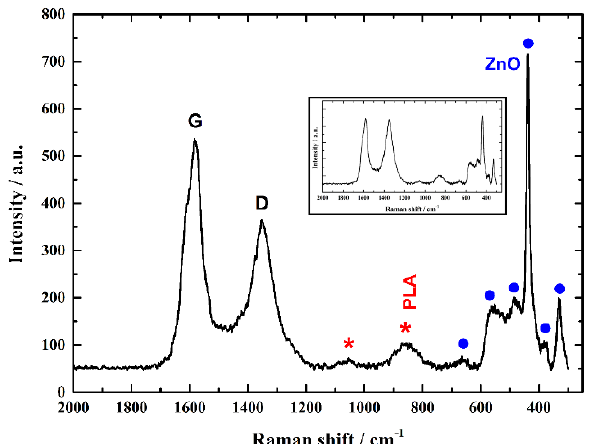
Figure 3. A typical Raman spectrum of ZnO/3D-printed graphene samples (PLA matrix and ZnO labeled with red asterisks and blue dots, respectively). In the inset of Figure 3, one can see a Raman spectrum at a different position of the same 3D-printed sample, indicating the uniform dispersion of ZnO on 3D-printed graphene pyramids.